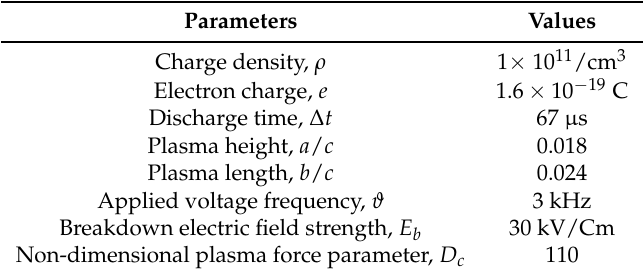
Table 3. Parametric values of the plasma body force modeling.